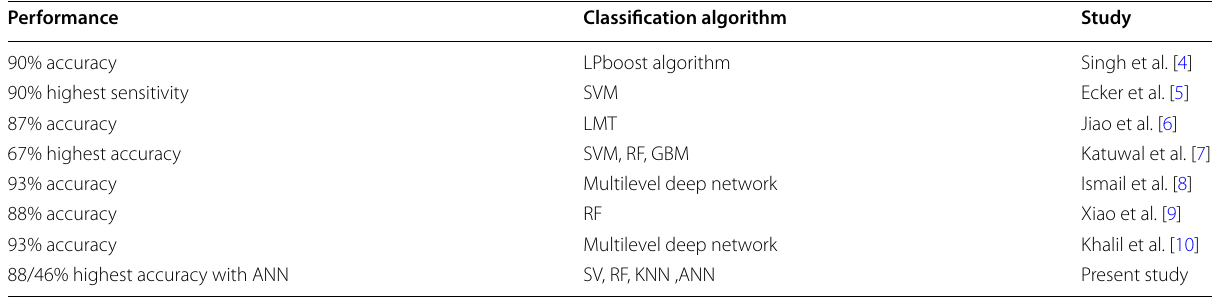
Table 7 Performance of the machine vision system using structural magnetic resonance imaging in past studies and present